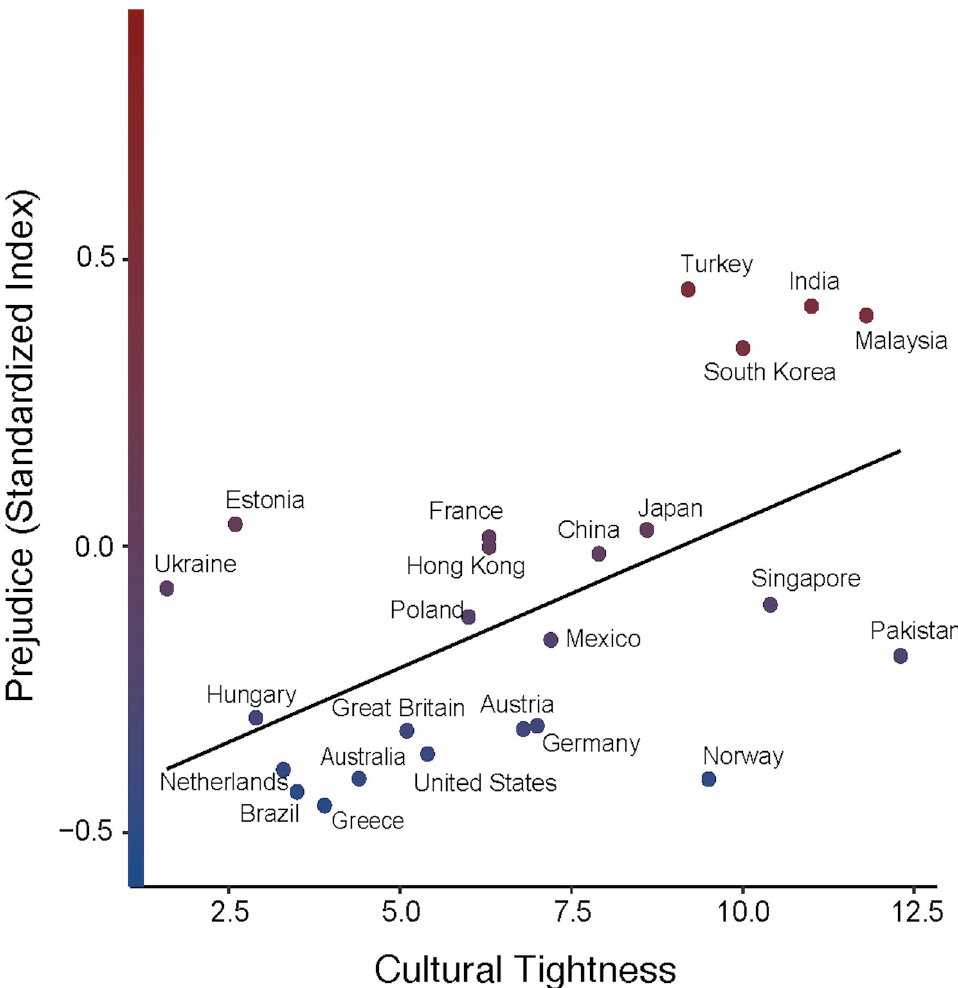
Fig 1. The relationship between cultural tightness and prejudice. Prejudice has been standardized in this figure. Prejudice is operationalized through the refusal to live next to individuals from seven commonly stigmatized groups.